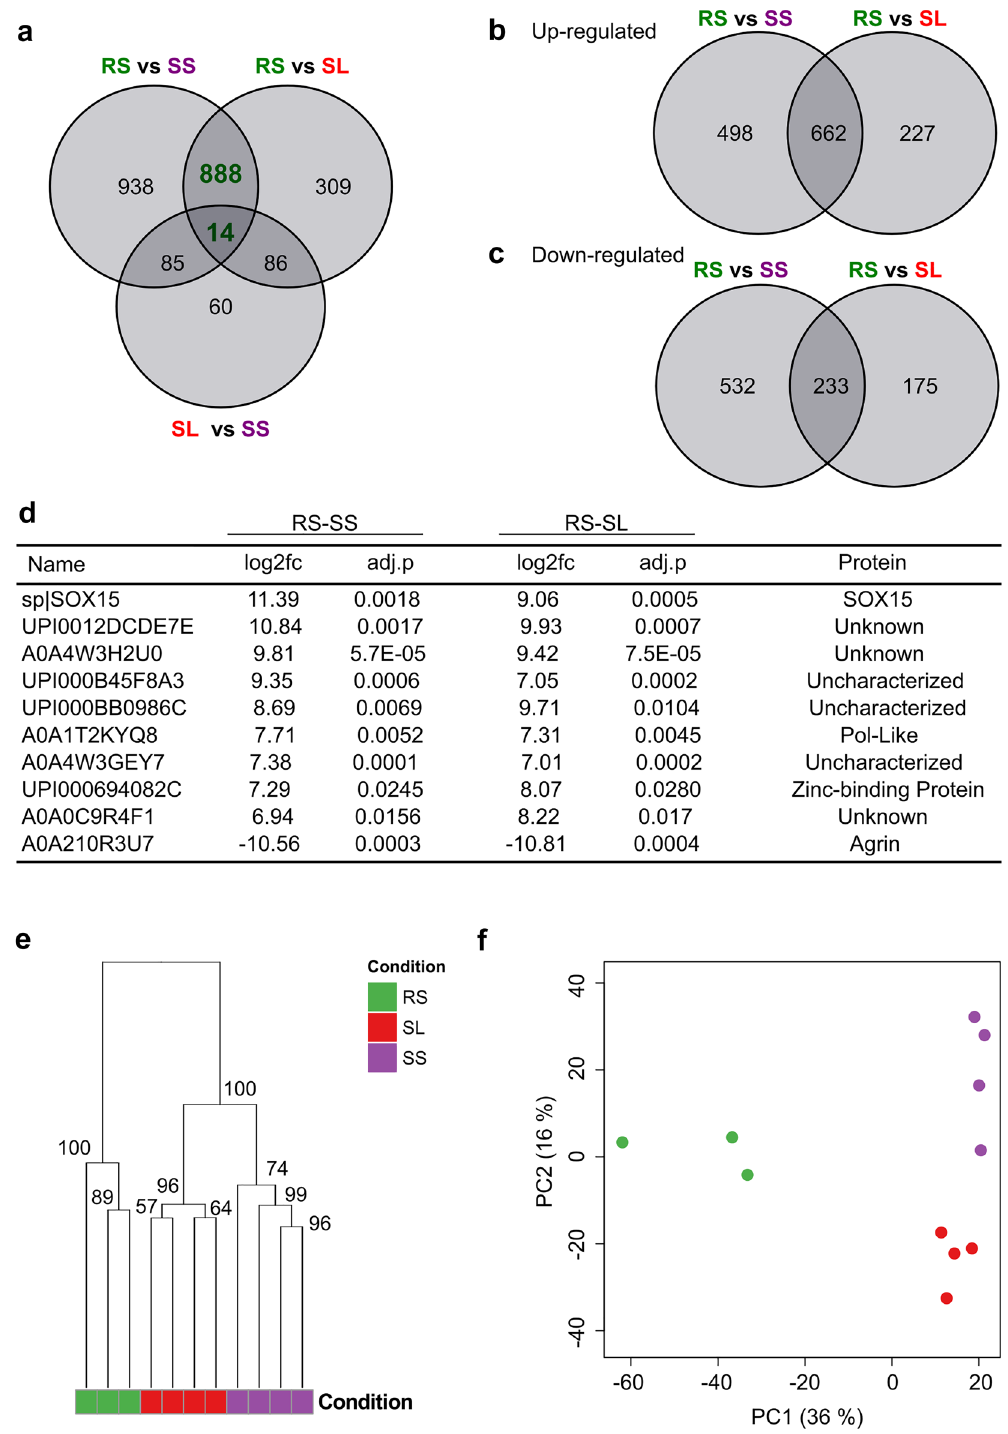
Figure 2. Resistant P. nobilis shows a specific differential expression genes profile. ( a ) Venn diagram showing the overlap of DEGs identified in RS vs SS, RS vs SL and SL vs SS. ( b ) Venn diagram showing the overlap of DEGs overexpressed in the two comparisons RS vs SS and RS vs SL. ( c ) Venn diagram showing the overlap of DEGs down-regulated in the two comparisons RS vs SS and RS vs SL. ( d ) 10 genes mostly significantly differentially regulated in both comparisons RS vs SL and RS vs SS and the protein associated. ( e ) Hierarchical clustering of samples (Ward’s method). The 1000 genes with highest variance were kept as dimensions. The percentage above each cluster divide represents the stability of the group as estimated by multiscale bootstrap resampling. Please note that the percentage that divides the clusters resistant with susceptible is equal to 100%. ( f ) Principal component analysis of samples. The 1000 genes with highest variance were kept as dimensions. RS, Resistant from sea; SS, Susceptible from sea; SL, Susceptible from